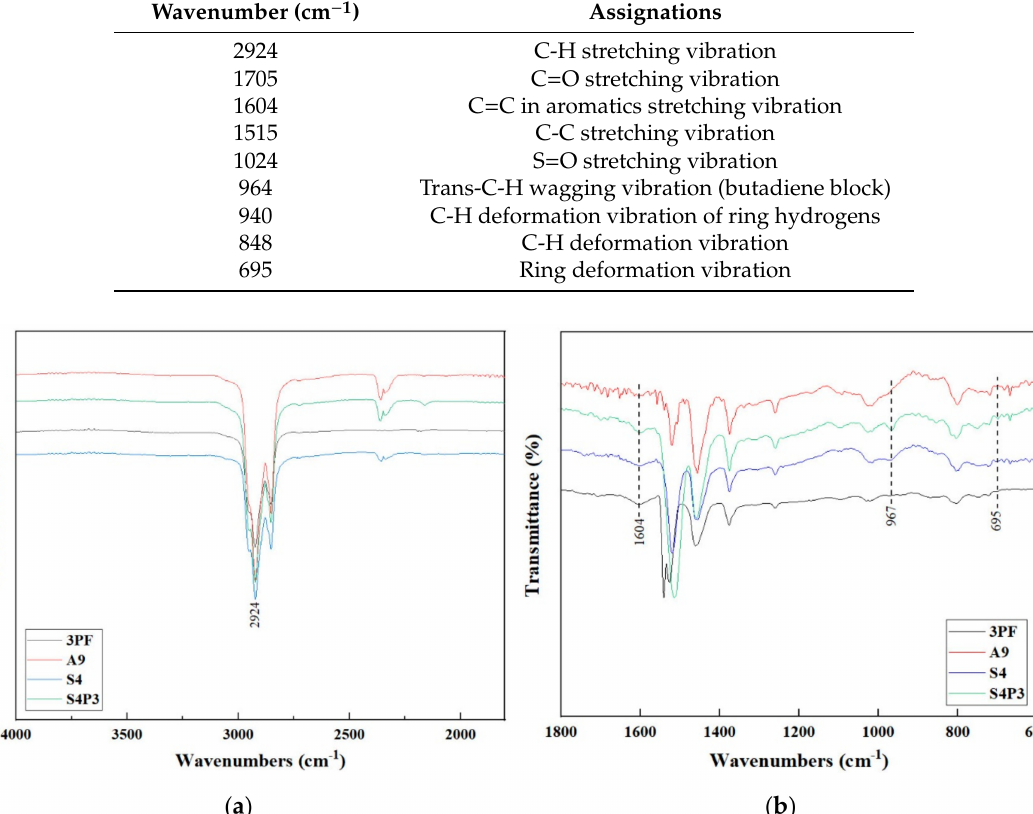
Figure 4. FTIR spectra of asphalt binder before aging. ( a ) 4000 to 1500 cm − 1 ; ( b ) 1800 to 600 cm − 1